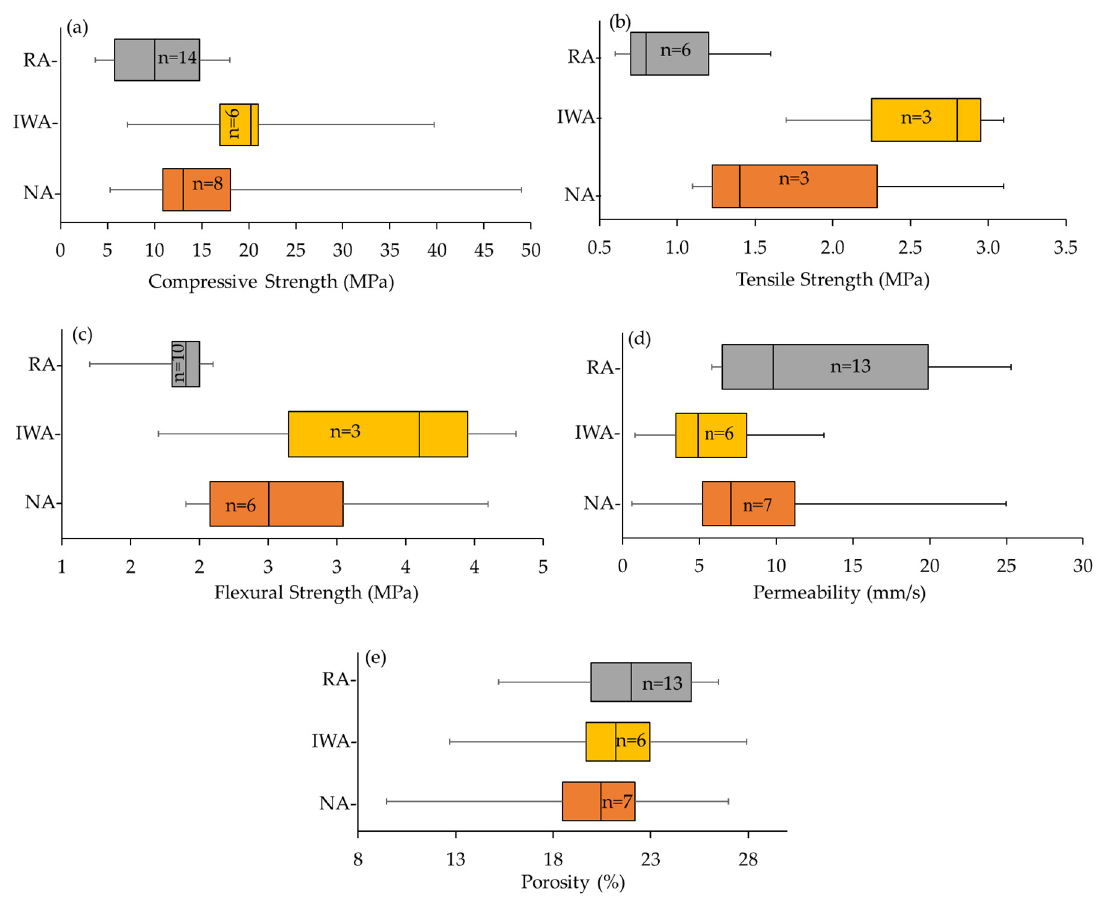
Figure 9. Variation in ( a ) Compressive strength, ( b ) Tensile strength, ( c ) Flexural strength, ( d ) Permeability, and ( e ) Porosity based on aggregate type (n = number of publications).